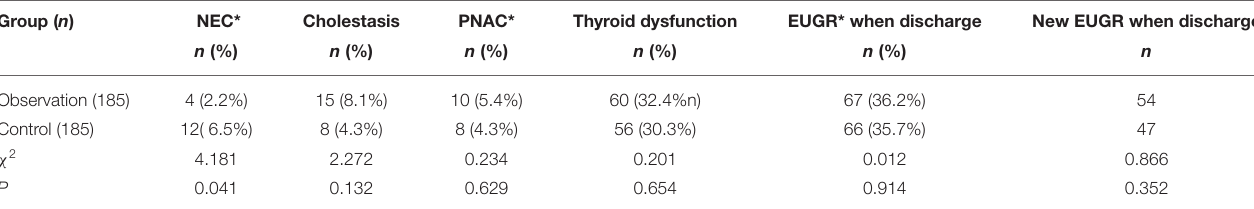
Observation (185)